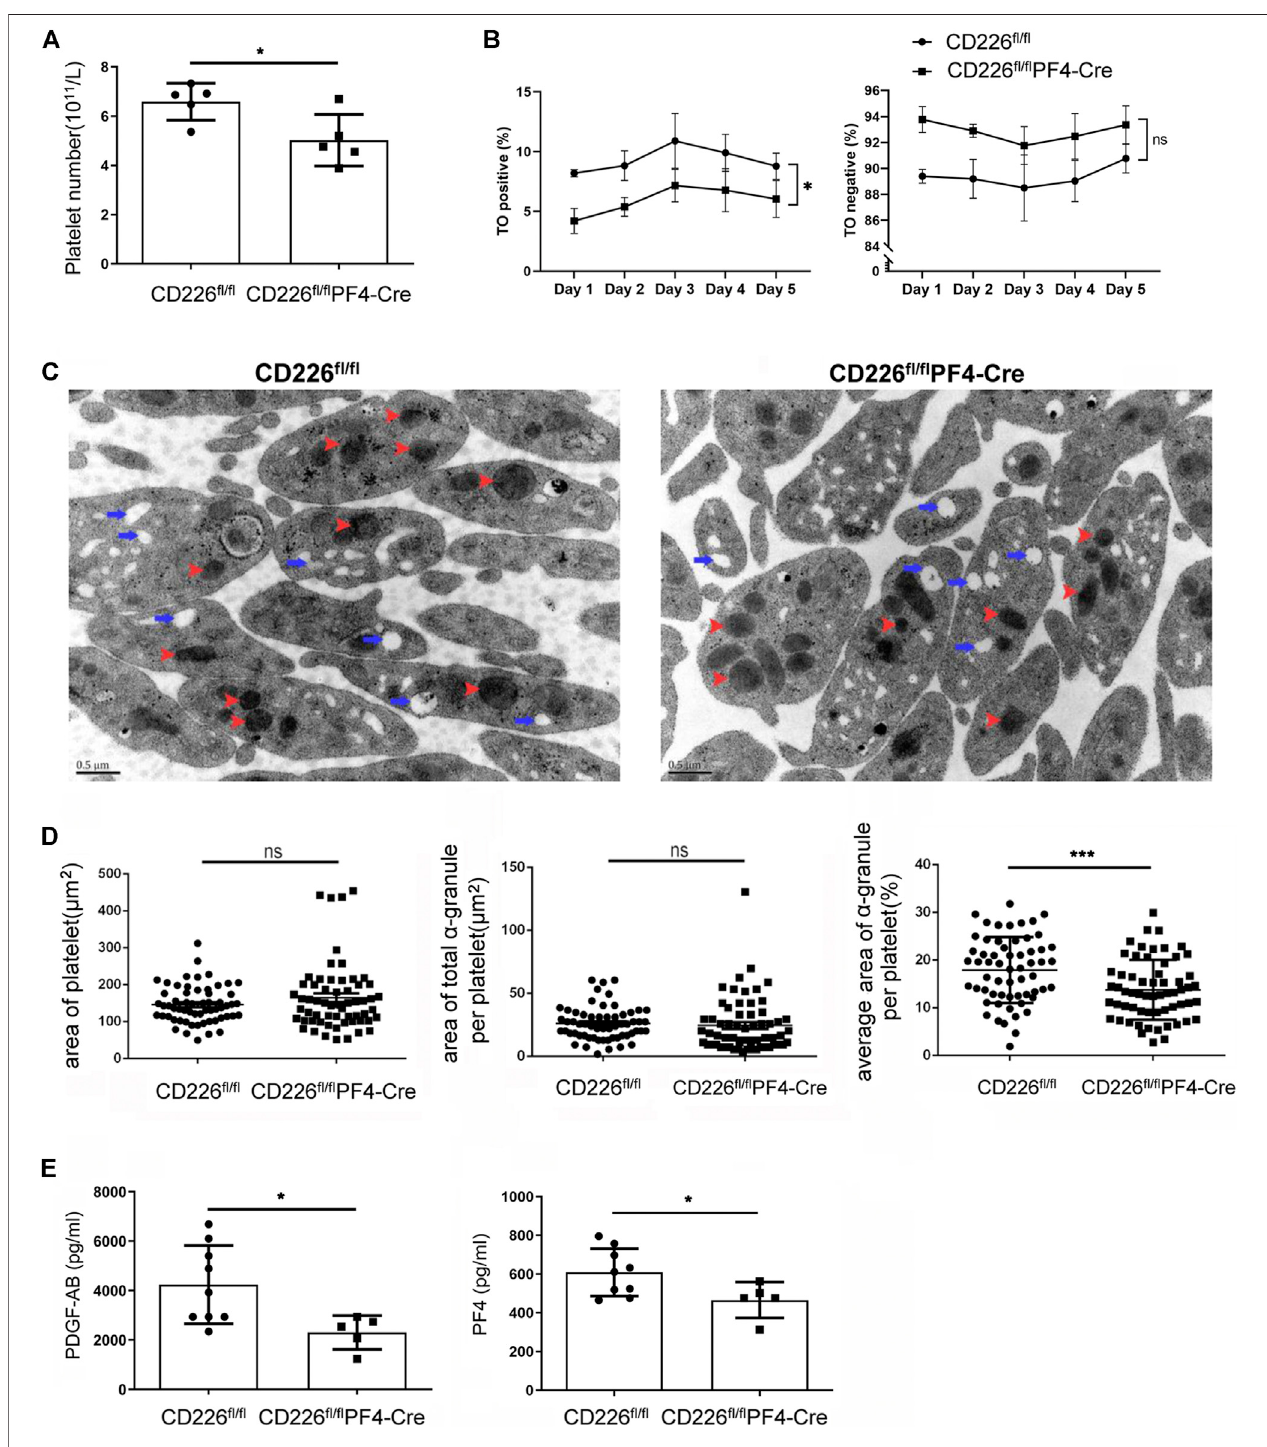
FIGURE2| AbsenceofCD226inplateletshinderedplateletmaturationandreduces α -granulesecretion. (A) Plateletnumberwasevaluatedby fl owcytometry. (B) Percentage of TO positive and negative platelets was measured to show the maturation of platelets. Two-ANOVA was adopted for statistical analysis over time. (C) Morphological changes of platelets. Red arrow: α -granule; blue arrow: dense-granule. (D) Area of platelet, area of total α -granule per platelet, and average area of total α -granuleperplateletwerecalculated. (E) ConcentrationsofPDGF-ABandPF4inserum.Statisticalsigni fi cancewasanalyzedbyindependent-sample t -testswith two-tailed p value. * p < 0.05, *** p < 0.001, ns (cid:1) no statistical signi fi cance.